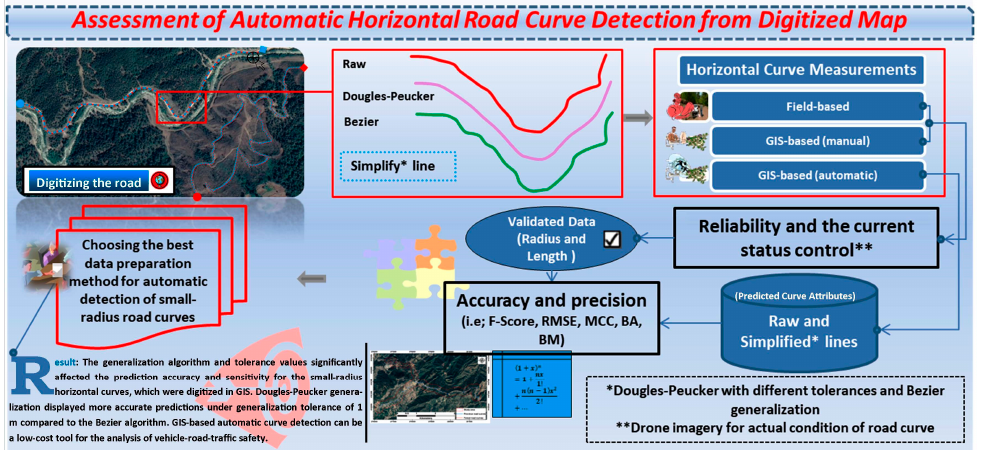
Figure 2. General workflow and brief explanation.